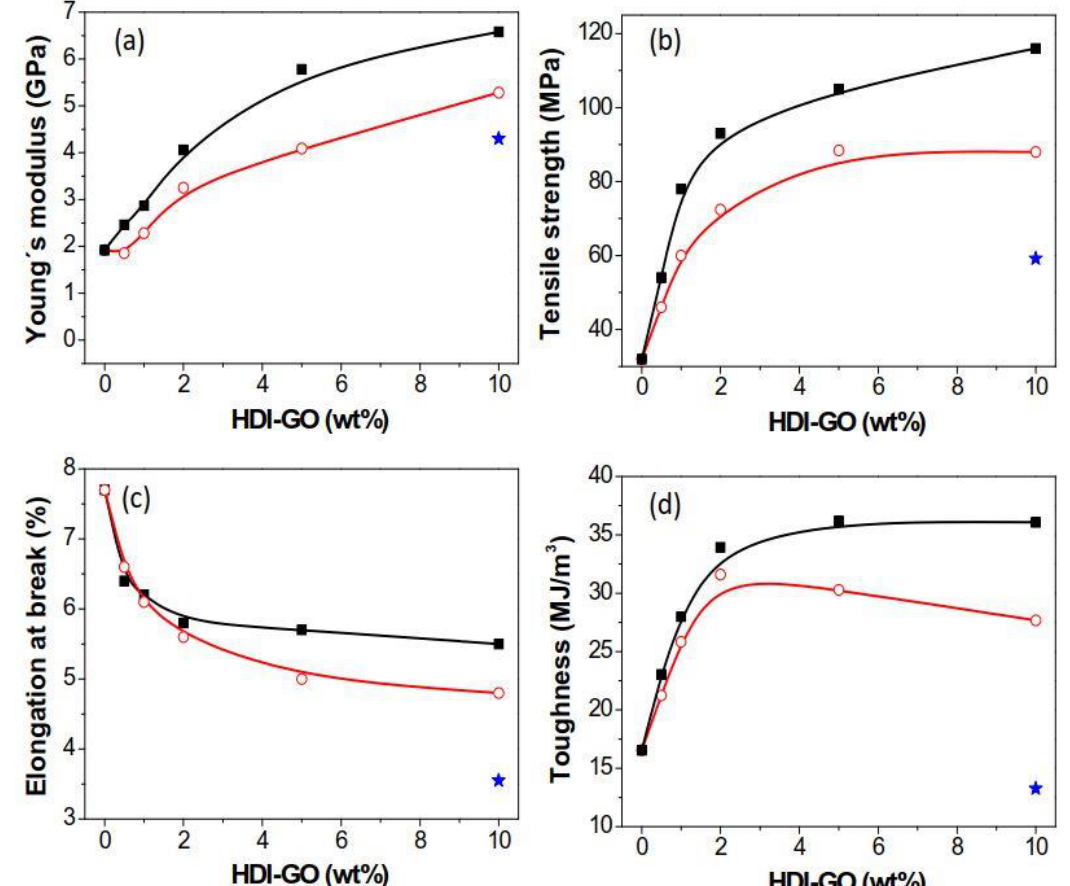
Figure 6. Results derived from tensile tests of PANI nanocomposites reinforced with HDI-GO 6 (solid squares) and HDI-GO 1 (open circles) as a function of the HDI-GO content. ( a ) Young’s modulus; ( b ) tensile strength; ( c ) elongation at break; ( d ) toughness. Solid lines are guides for the eyes. The blue star corresponds to the PANI/GO (10 wt %) reference composite.